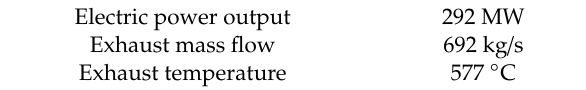
Table 1. Siemens SGT5-4000F turbine parameters [26].